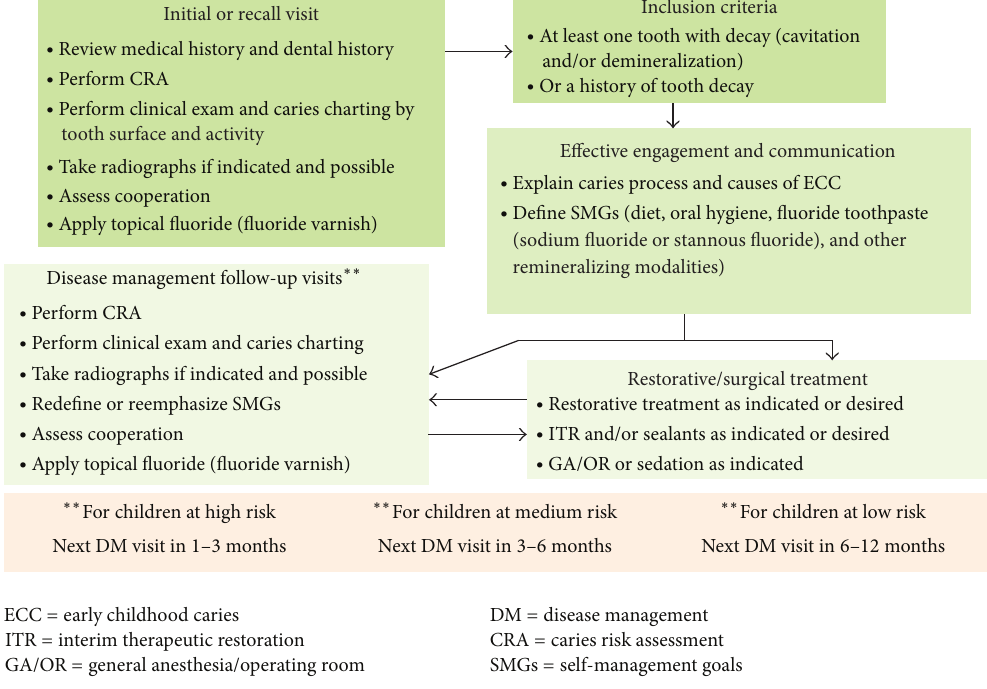
Figure 2: ECC Phase 2 disease management clinical